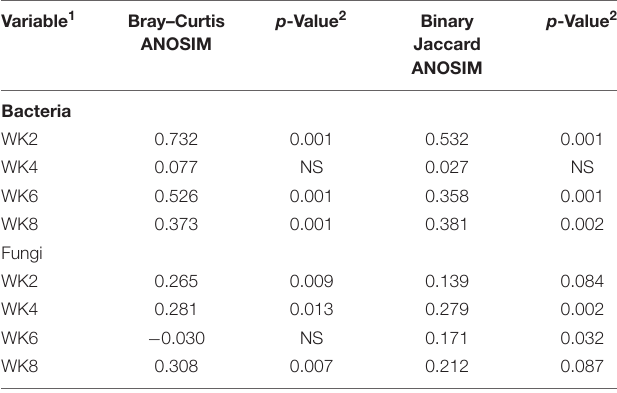
TABLE 5 | Analysis of similarity (ANOSIM) of multispecies probiotics on fecal bacteria and fungi of Holstein dairy calves. Variable 1